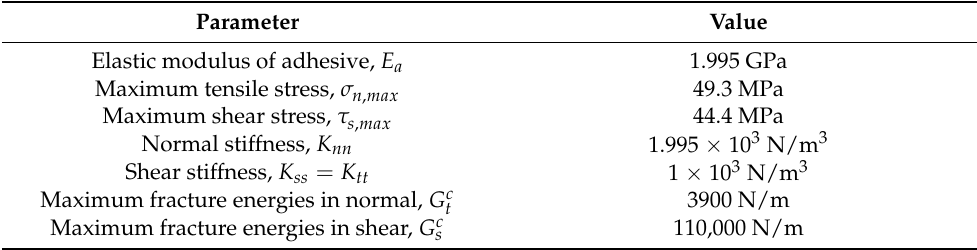
Table 8. Input material properties of adhesive (epoxy) (Adapted from